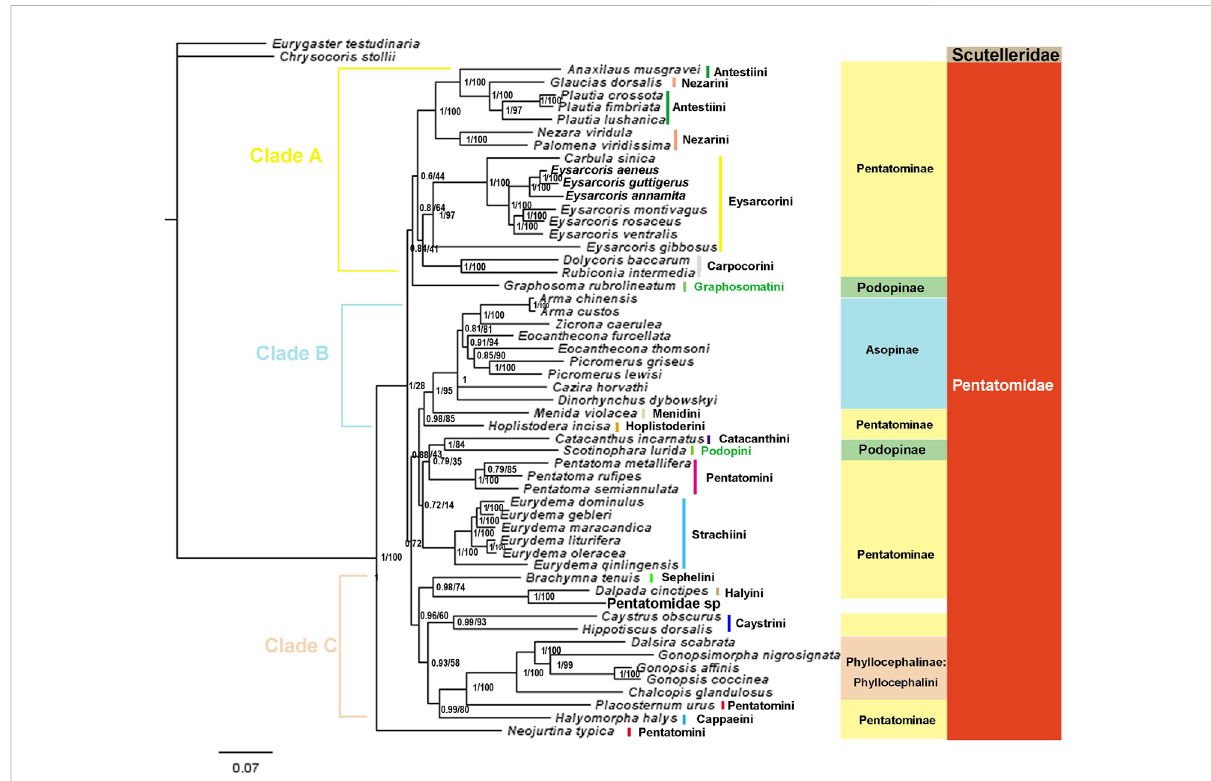
FIGURE 11 The phylogenetic trees of tribes within Pentatomidae were constructed from DNA sequences of 13 PCGs excluding the third site using BI and ML methods. Numbers on branches are posterior probabilities (PP, left) and bootstrap (BS, right). Note: Branches without BS values indicate that the topology is only supported by